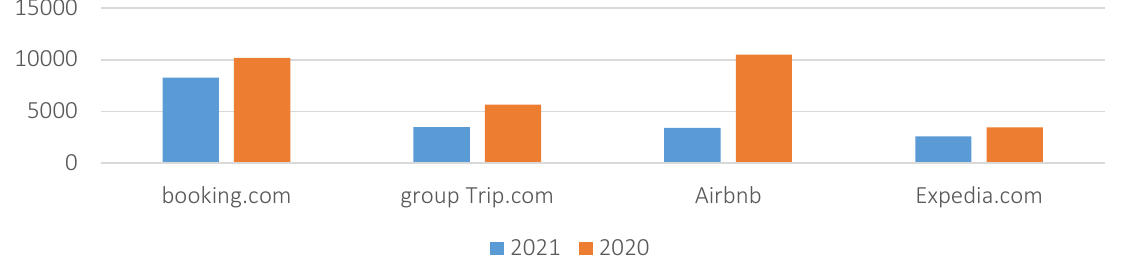
Figure 3. Dynamics of operational activity indicators of brand distributors